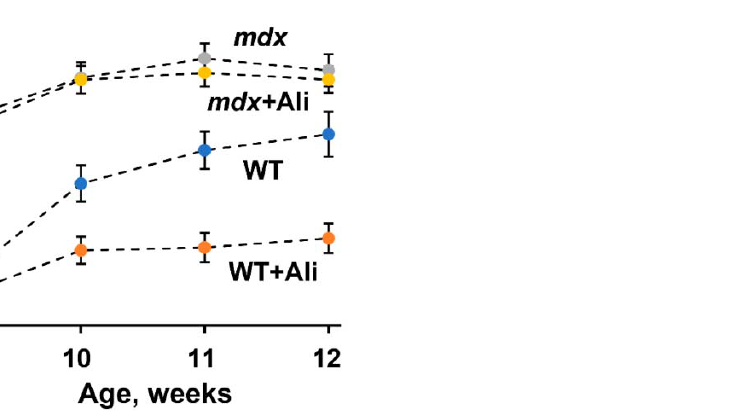
Figure 3. The effect of alisporivir treatment on body weight gain in experimental groups of mice. The data are presented as means ± SEM ( n = 10).